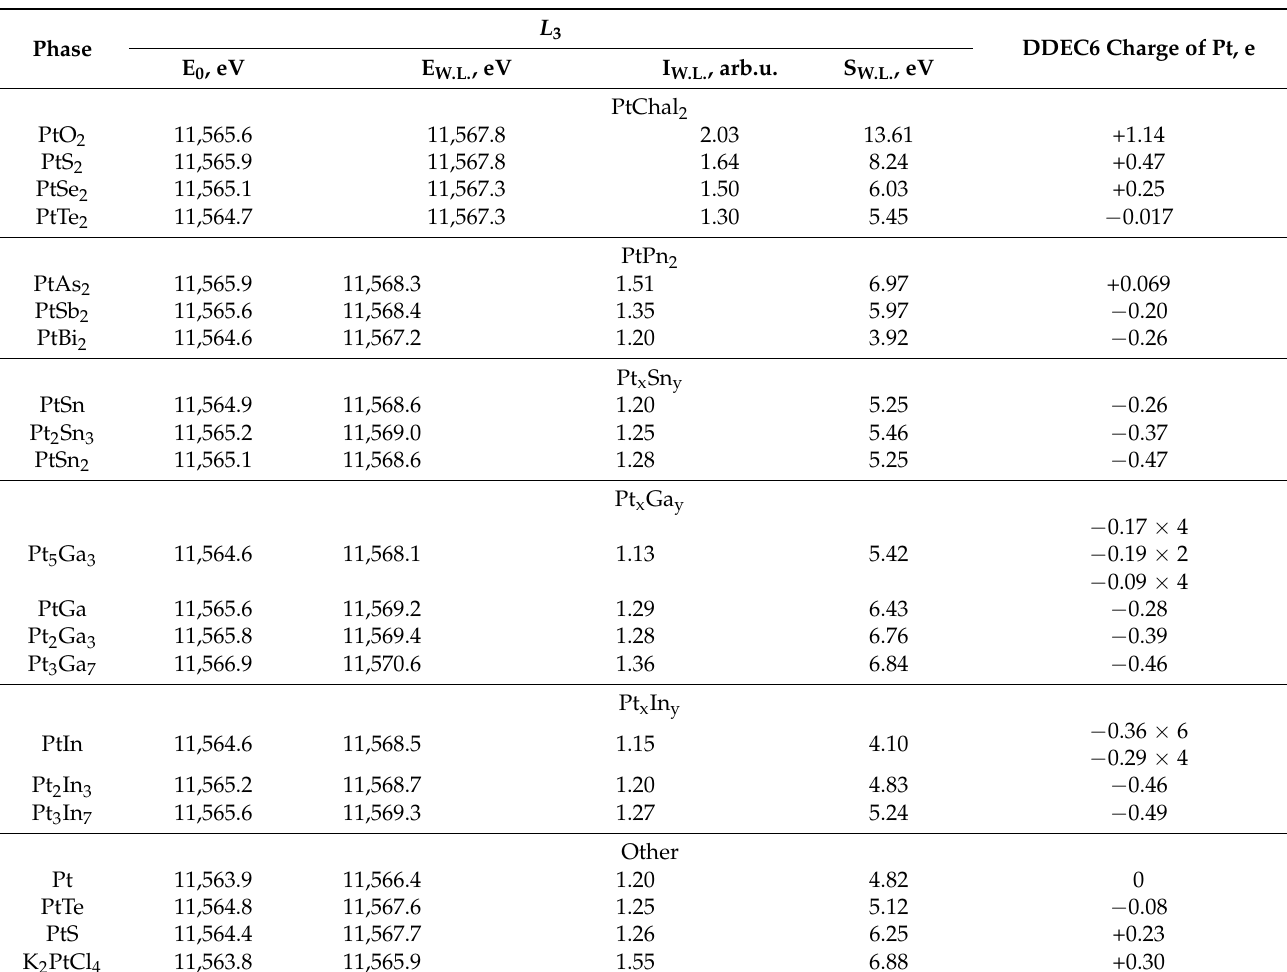
Table 3. Results of Pt L 3 XANES spectra deconvolution obtained using Athena